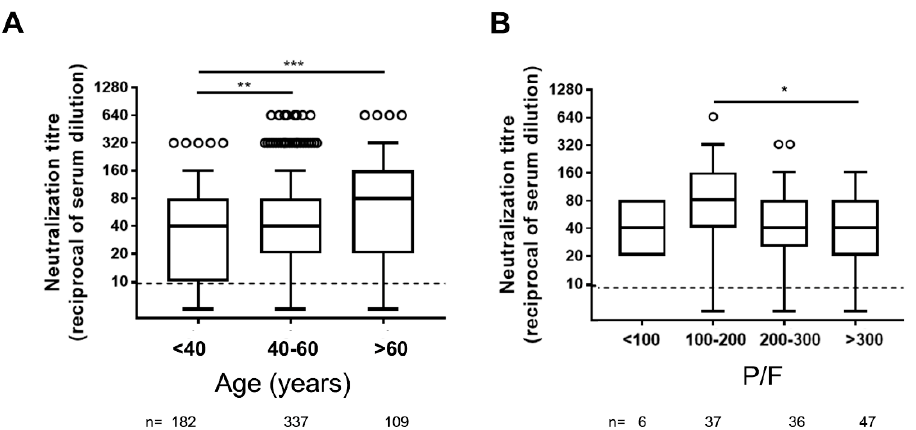
Figure 1. Neutralizing antibody titers in different ages ( A ) and COVID-19 severity ( B ) groups of symptomatic COVID-19 patients. P/F = arterial pO2 divided by the fraction of inspired oxygen (FiO2) used as correlate of diseases severity. Dot line indicates the limit of neutralizing antibody (NAb) quantification, n = number of patients tested. Statistical analysis was performed by Mann–Whitney test p values < 0.05, < 0.01, < 0.001 are indicated as *, **, and *** respectively.